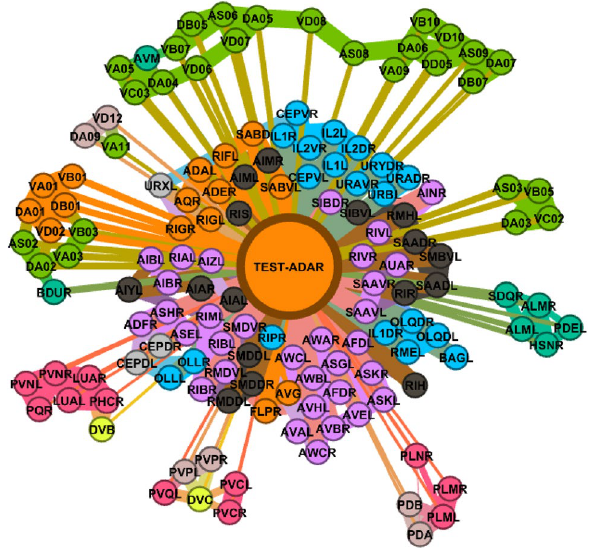
Figure 8. Sample visualization of the prediction step. Test node ADAR from the C. elegans dataset has been classified as CL-E